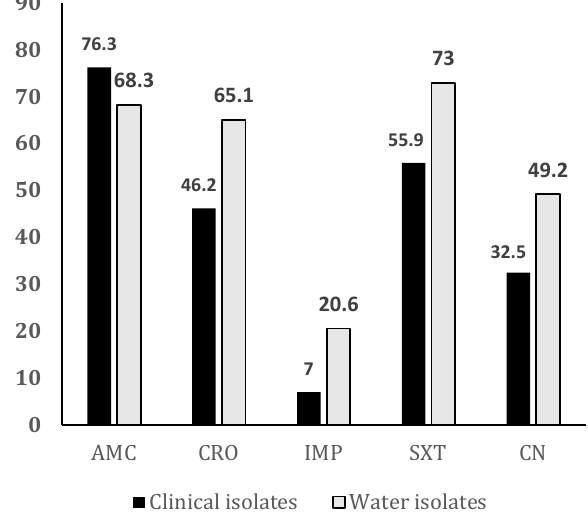
Water isolates Figure 2. MDR correlation between clinical [44] and water sources isolates of E. coli in